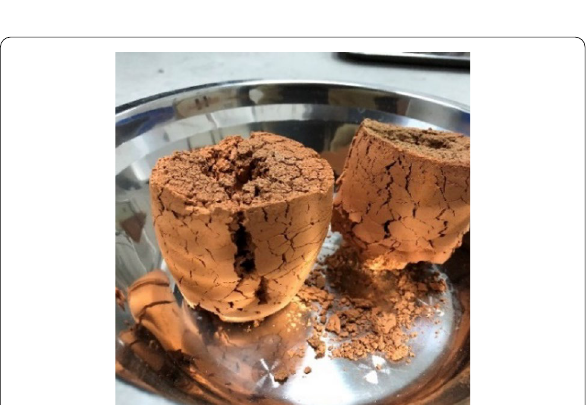
Fig. 3 Attapulgite calcined at 700 ℃ for 2 h (fully